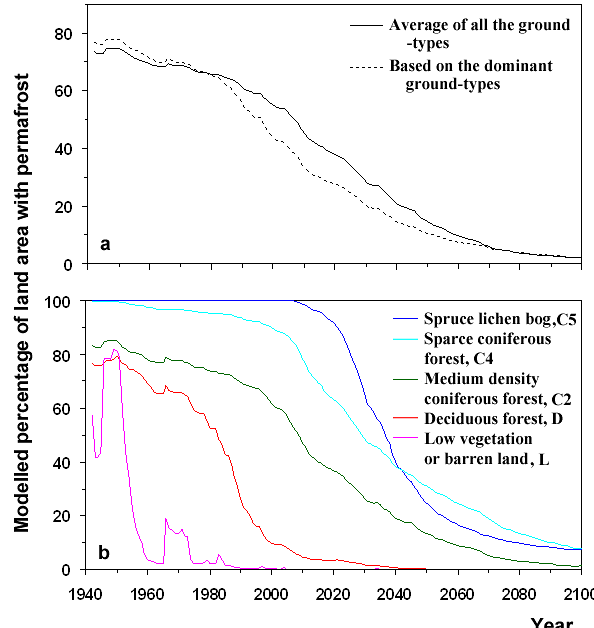
Figure 6. The modelled temporal changes of permafrost probability (a) for the entire study area and (b) for five selected land cover types in this